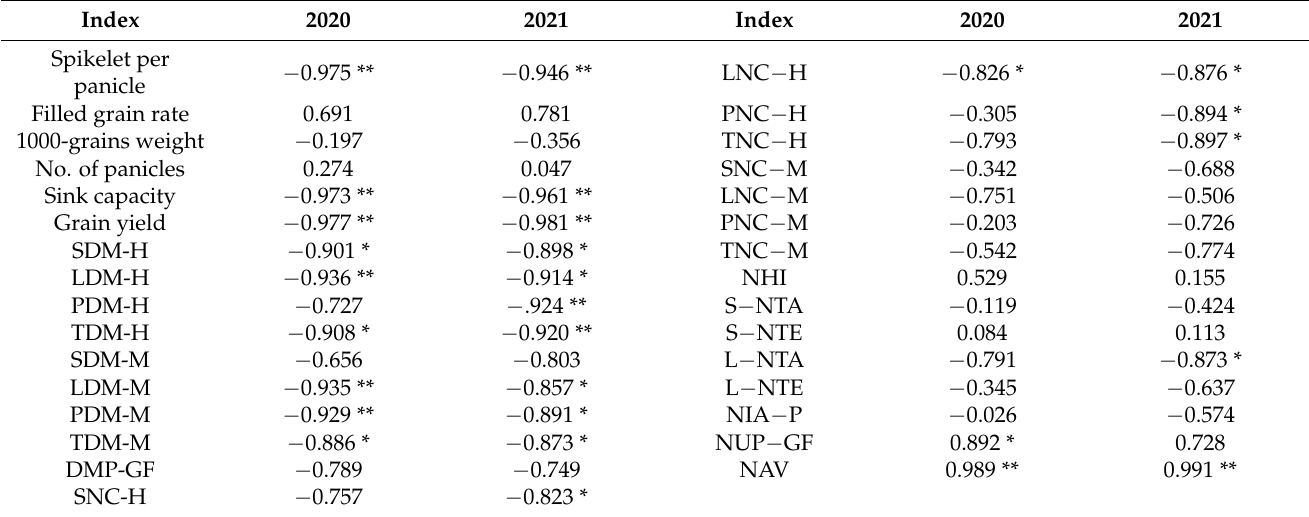
Table 6. Correlations of grain yield, dry matter production, nitrogen uptake and translocation with GPC.